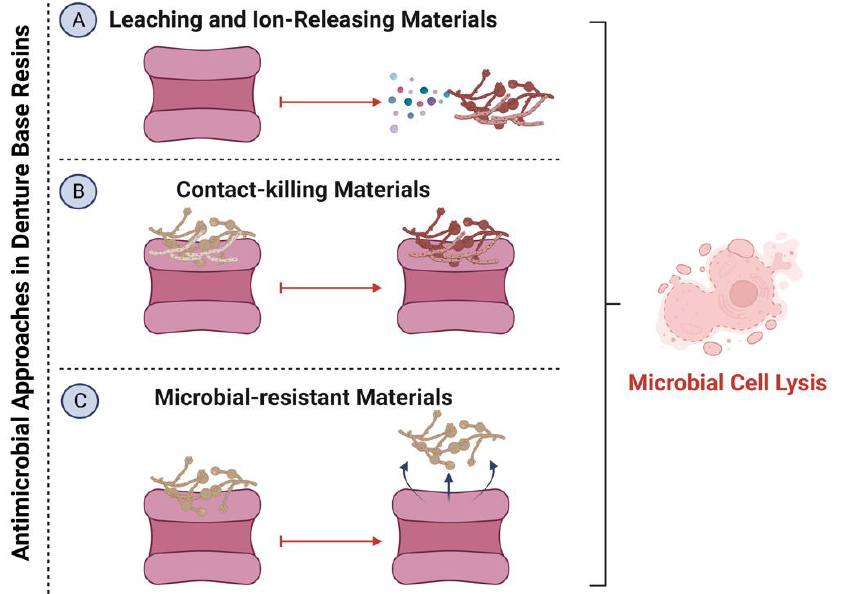
Figure 2. Scanning Electron Microscope (SEM) images of the black substrate and the microbial cells: